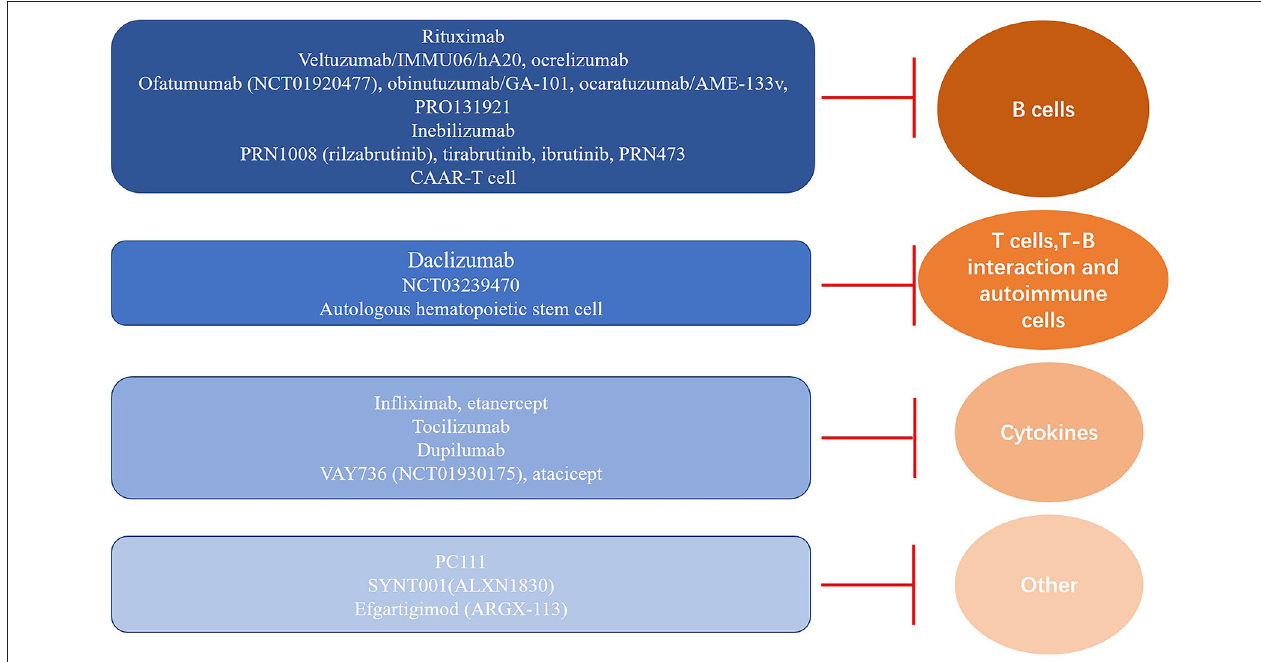
FIGURE 2 | Immune pathomechanism-based targets and classification of therapeutic agents for pemphigus. Overview of the current and candidate agents for immunotherapy and their corresponding targets, including B cells, T cells, and cytokines, which are essential for pathogenic autoantibody production and secretion in